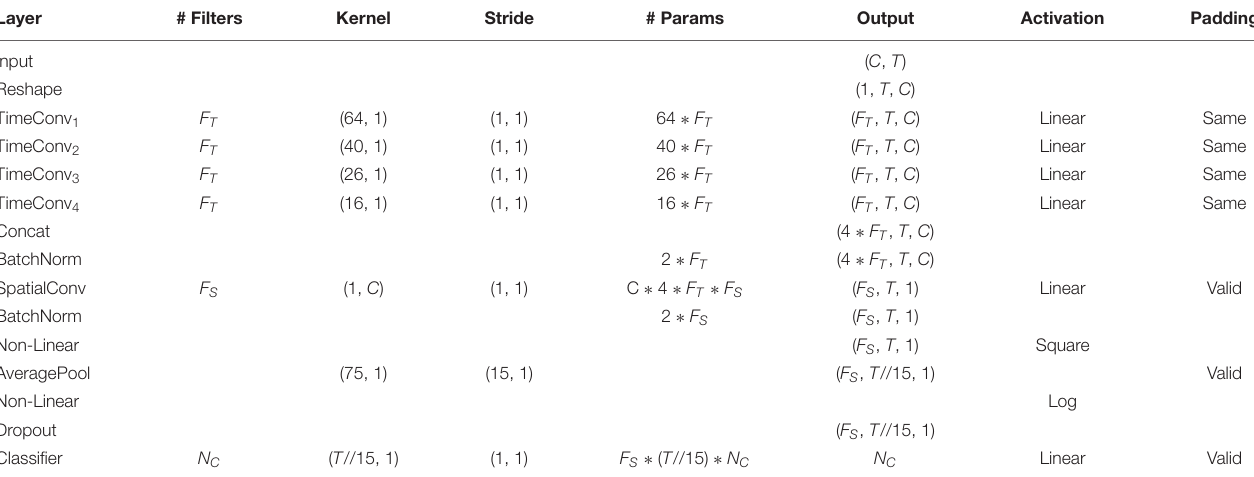
TABLE 1 | Detailed architecture of the proposed